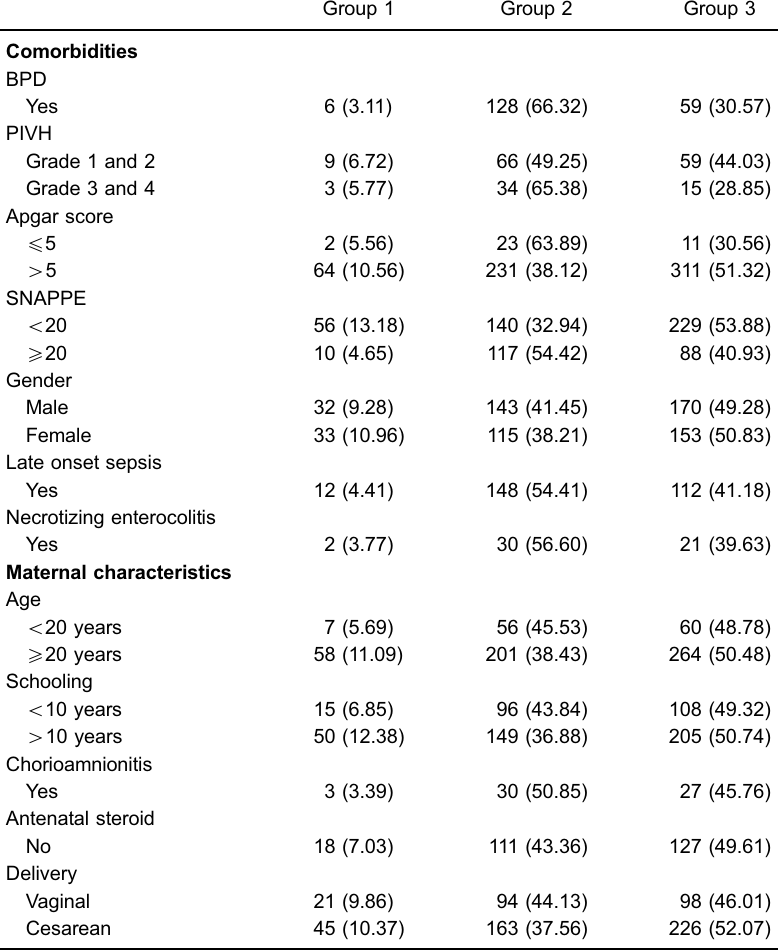
Table 1. Characteristics of the mothers and comorbidities of the newborns according to type of feeding at discharge.